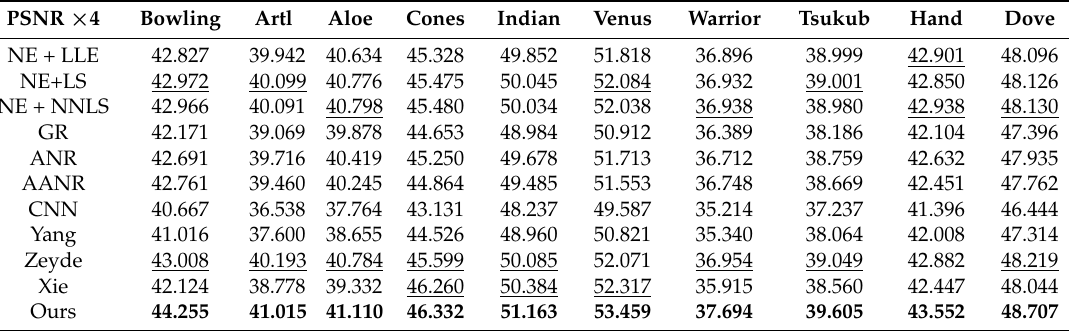
Table 3. PSNR values on the Middlebury Stereo database with scaling factor of